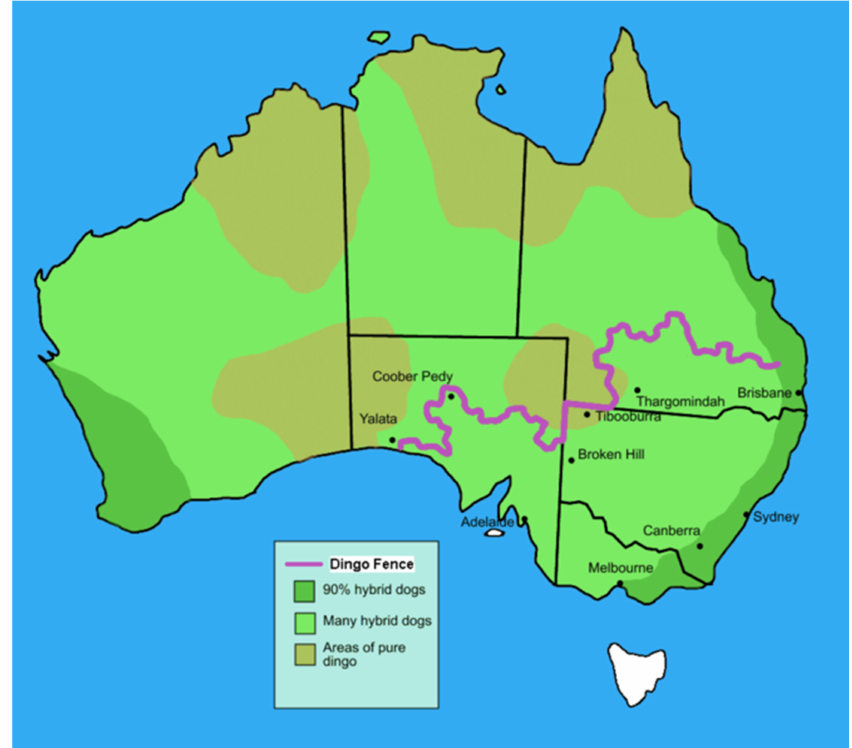
Figure 4. Dingo (or wild dog) barrier fence across Queensland, New South Wales and South Australia (source: https://commons.wikimedia.org/wiki/File:Dingo_fence_in_Australia.PNG; accessed on 21 April 2021). Note, there is a non-contiguous barrier fence (not shown) from the south-east to the north-west of Western